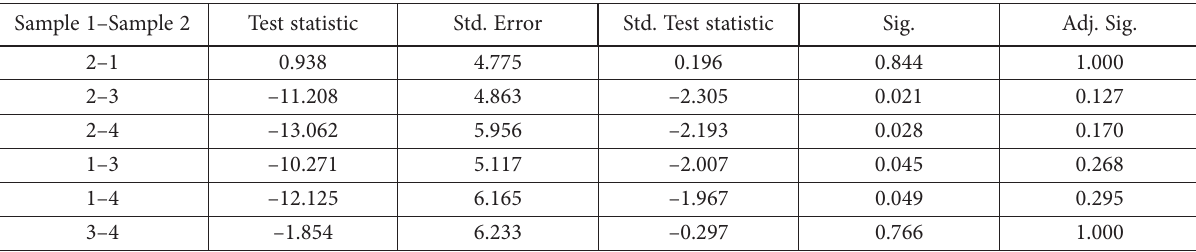
Table 8. Pairwise cluster comparison for differences in office ownership adjustments using Dunn–Bonferroni test Sample 1–Sample